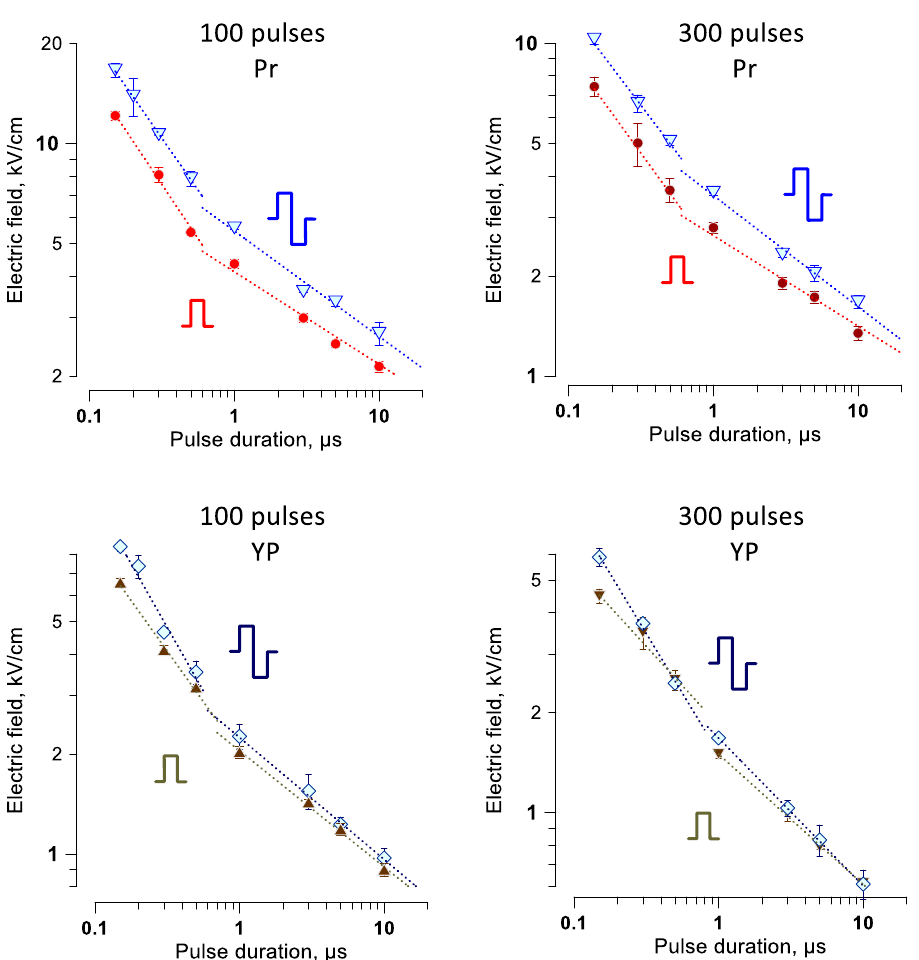
Figure 7. The addition of the opposite polarity second phase increases the threshold for cell killing and electroporation. The thresholds were measured by the margins of Pr and YP uptake and are presented at the top and bottom panels, respectively (see Fig. 6 and text for details). The data for unipolar PEF are the same as in Fig. 6. Cells were exposed to trains of 100 or 300 pulses at 10 Hz. For bipolar pulses, the duration of a single phase was used in lieu of the total pulse duration. Note that the difference in thresholds becomes larger for shorter pulses. Differences between uni- and bipolar pulses for Pr uptake thresholds were statistically significant for 12 out of the 14 datapoints. Differences in YP uptake were significant only for the shortest pulses (two-tailed t test at p <